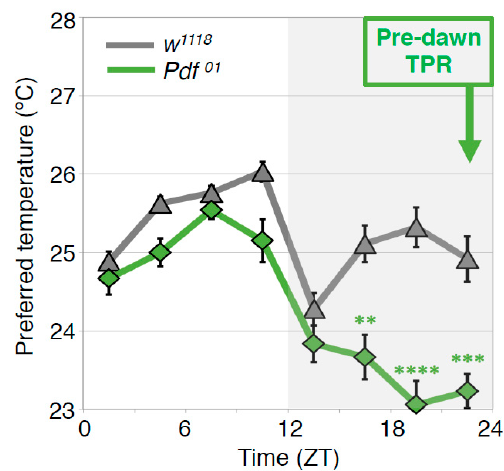
Figure 6. PDF regulates the predawn TPR. Comparison of TPRs between w 1118 and Pdf mutant ( Pdf 01 )